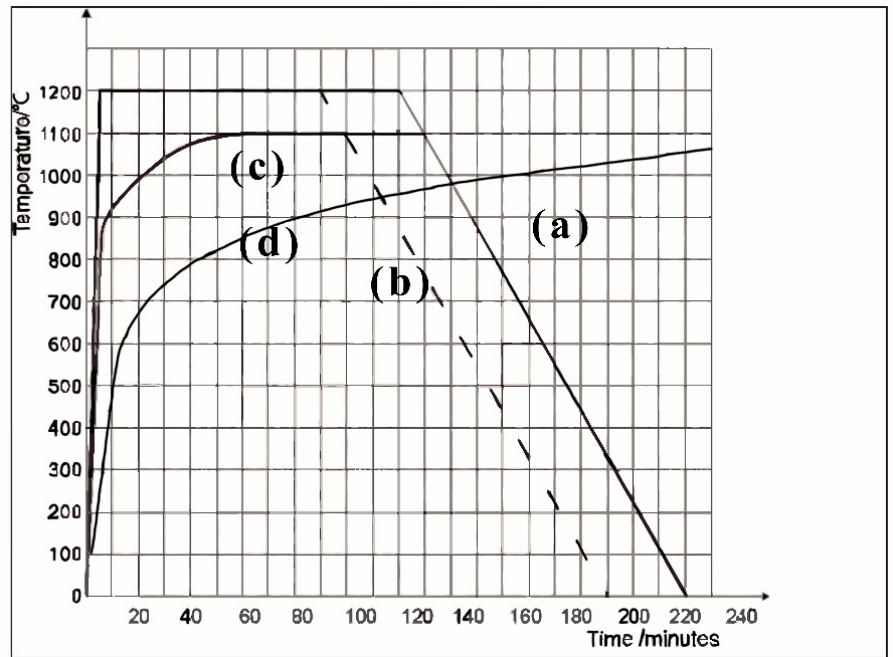
Figure 5. Four types of RABT curves: ( a ) 3.8 h for hydrocarbon fire; ( b ) 3.3 h for hydrocarbon fire; ( c ) 3.8 h for electric fire; ( d ) building-fiber fire.